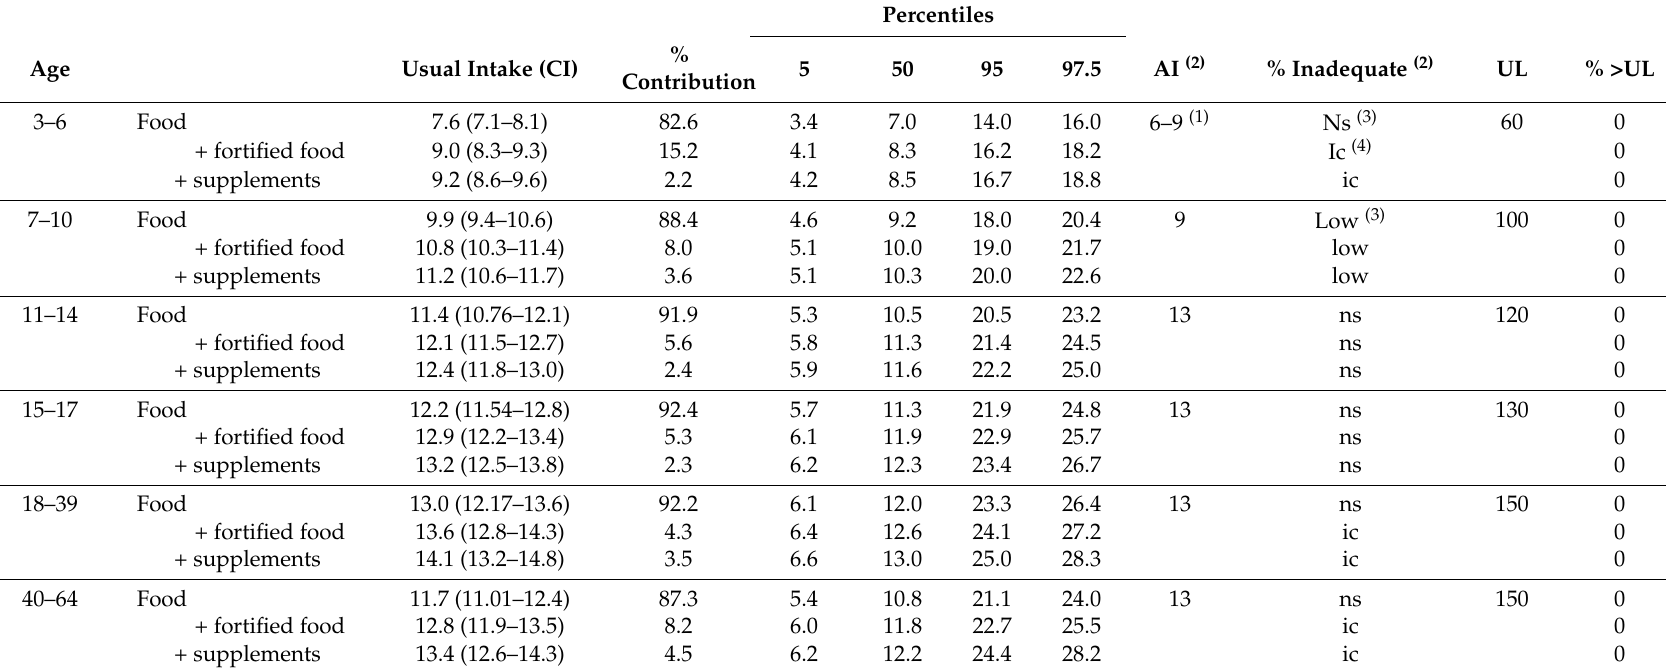
Table 7. Usual intake of vitamin E (mg/day) from food, fortified food and supplements in Belgian men (3–64 years), Belgian study on the intake of vitamins A, D, E and K (VITADEK-study)